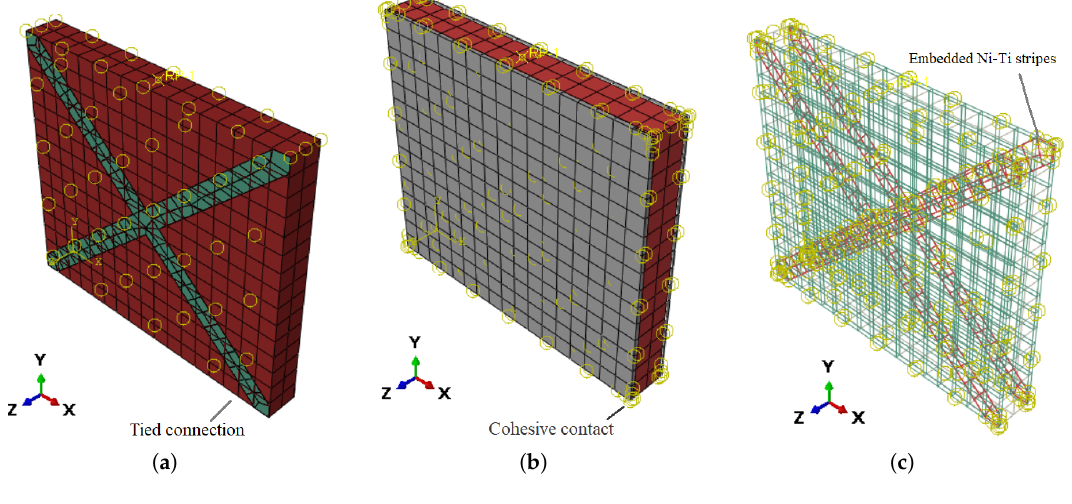
Figure 8. Interactions between different parts and the URM; ( a ) Ni–Ti strips; ( b ) ECC sheets; ( c ) em- bedded Ni–Ti strips in the ECC